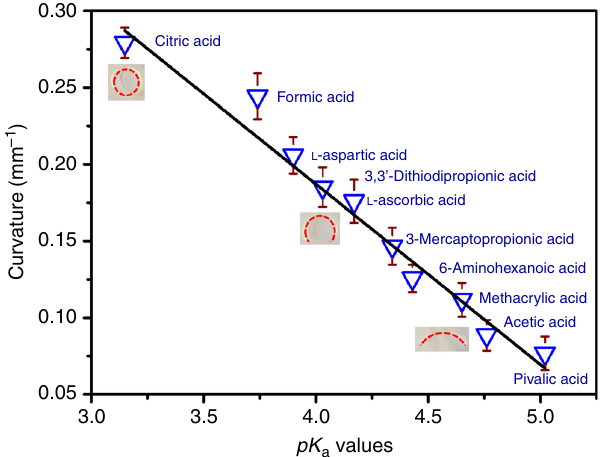
Fig. 4 The detection of a broad range of weak-acids with different pK a values by Ptriaz-TA membrane actuator. The experiment was conducted by immersing a membrane stripe (1 mm × 25 mm × 80 µ m) in a.q. solutions of weak acids at a concentration of 3 × 10 − 4 M. Insets: photographs of the membrane stripe at different acid solutions. The red dashed line in the insets indicates the membrane bottom. The black line is a linear fi t of curvature vs. pK